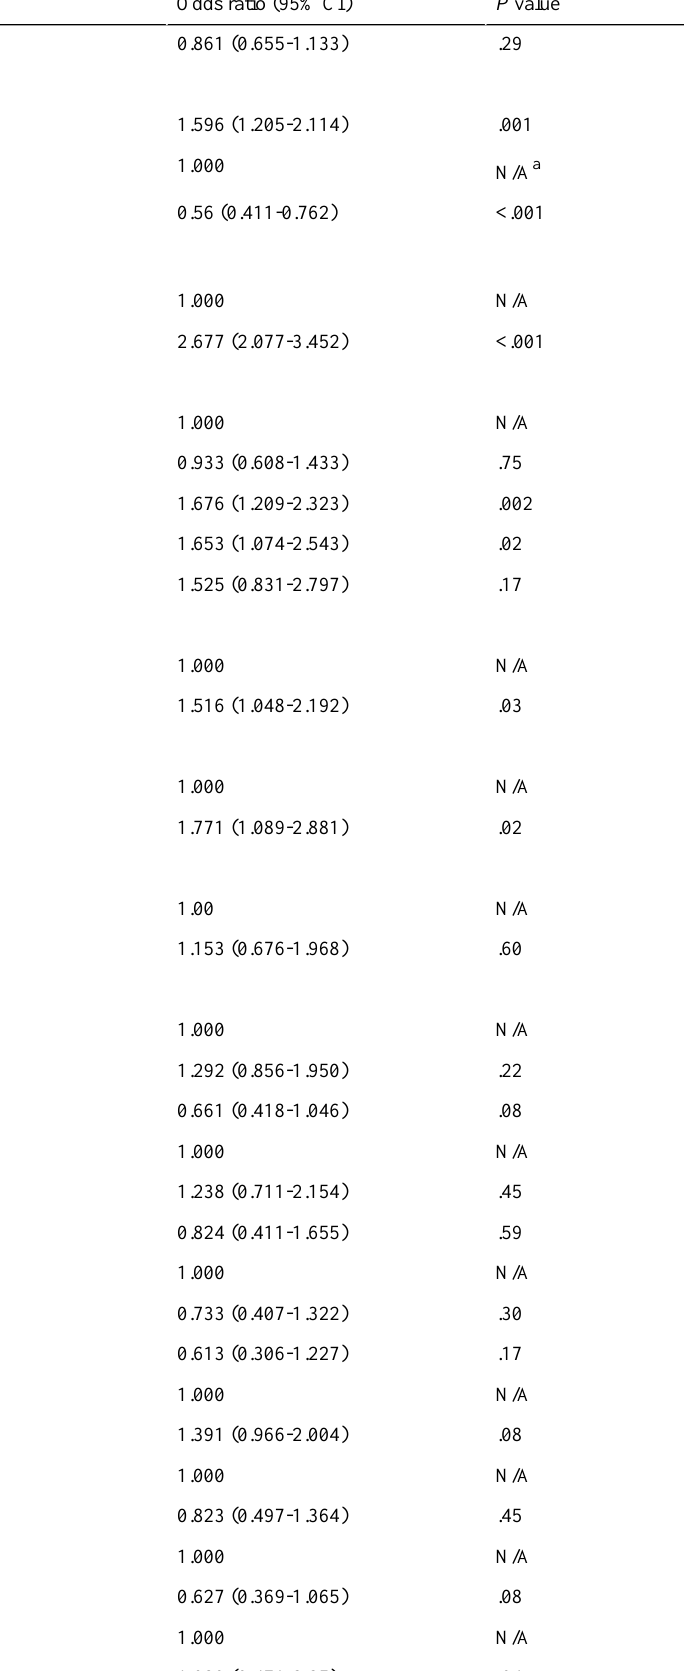
Table 1. Logistic regression examining the associations between demographic characteristics, substance use, and the interaction between demographic characteristics and substance use with the likelihood of any Instagram